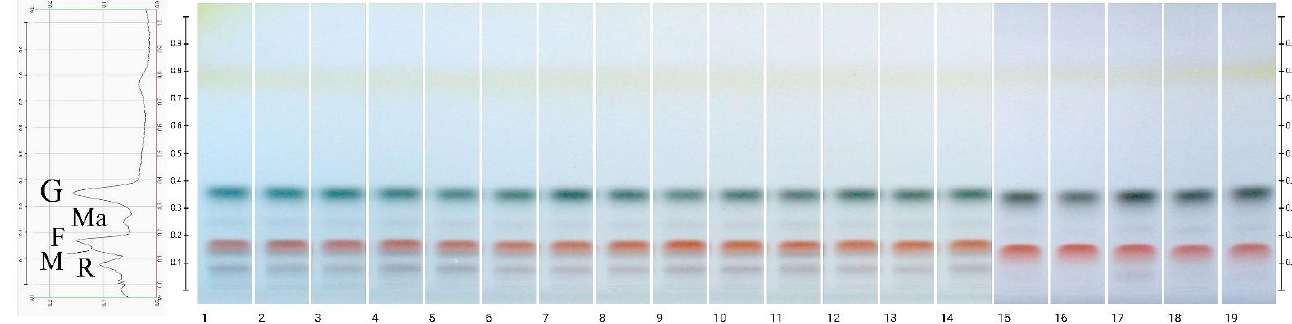
Figure 1. Images of HPTLC plates taken after derivatization by aniline—diphenylamine—phosphoric Figure 1 . Images of HPTLC plates taken after derivatization by aniline‒diphenylamine‒phosphoric acid reagent in visible light, presenting sugars separation. Tracks 1–14—honeydew honeys, 15— acid reagent in visible light, presenting sugars separation. Tracks 1‒14— honeydew honeys, 15 — heather, 16 — acacia, 17 — multifloral, 18 — buckwheat, 19 — rape honeys. (R — raffinose, M — heather, 16—acacia, 17—multifloral, 18—buckwheat, 19—rape honeys. (R—raffinose, M—melezitose, melezitose, F — fructose, G — glucose, Ma — Maltose) . F—fructose, G—glucose,